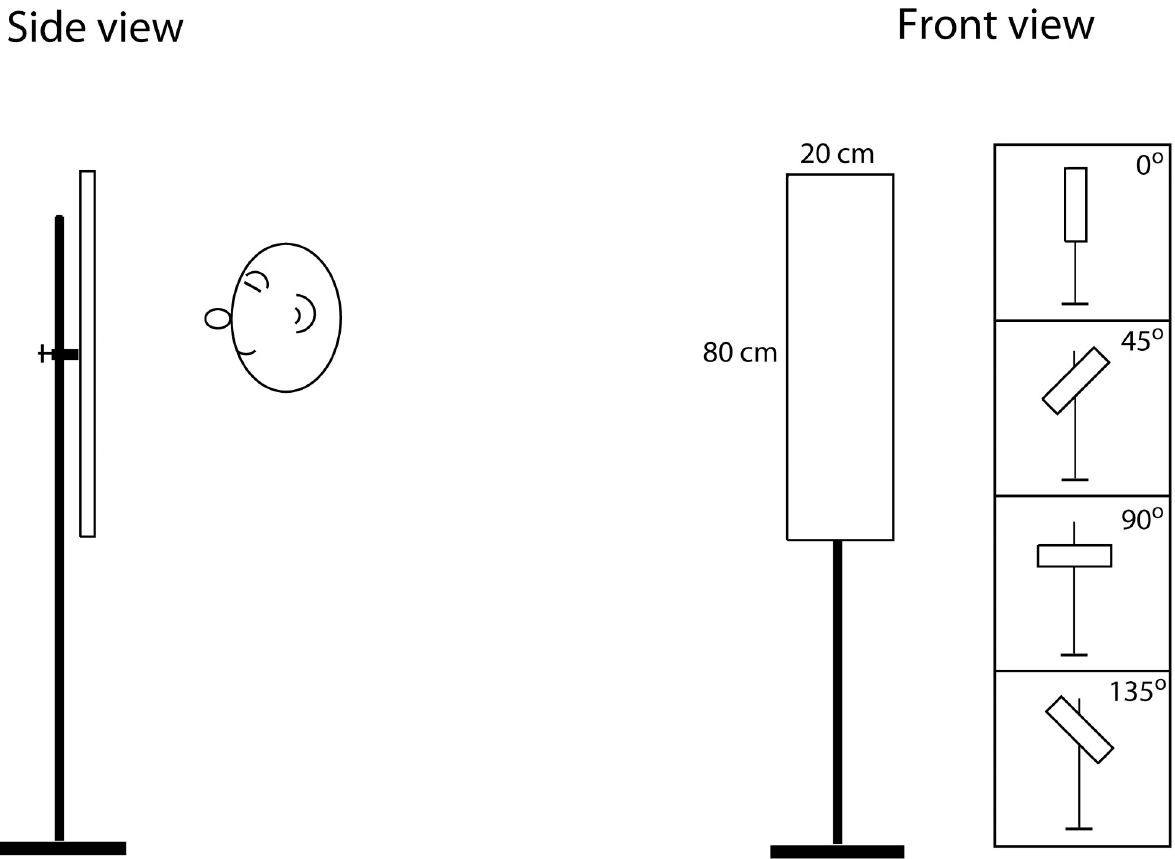
Fig 3. Illustration of the apparatus used for the orientation perception task. The inset on the left illustrates the different orientations the rectangle could be presented at, i.e. vertical, right side up (45˚), horizontal, or left side up (135˚), always facing the